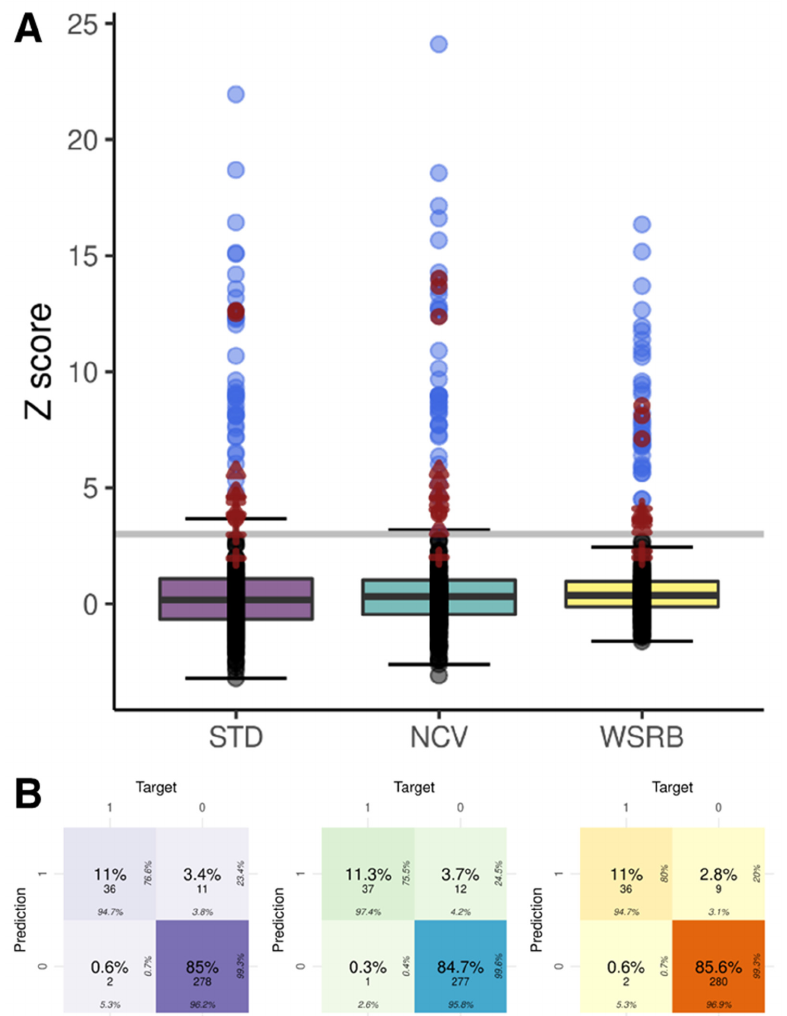
Figure 3. NIPT results of 109 samples obtained using three methods (STD, NCV, and WSRB). ( A ) Boxplots of Z-scores of three methods. Gray line represents the cutoff of detection of trisomy (Z-score = 3.0). An open red circle represents the chromosome 13 of a sample that differs between a NIPT result and a secondary test, an open red triangle represents chromosome 18 showing the dif- ference, and a red plus represents chromosome 21 showing the difference. ( B ) Confusion matrix of prediction with Z-scores for three chromosomes (chr 13, 18, and 21) of three different methods. Value of 0 represents a normal (not trisomy) sample and 1 represents a trisomy. Graph colors are different according to the specific method (STD: purple, NCV: turquoise, WSRB: yellow).